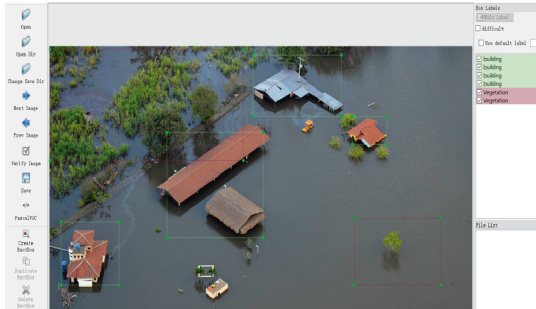
Figure 8: Training data labeling.